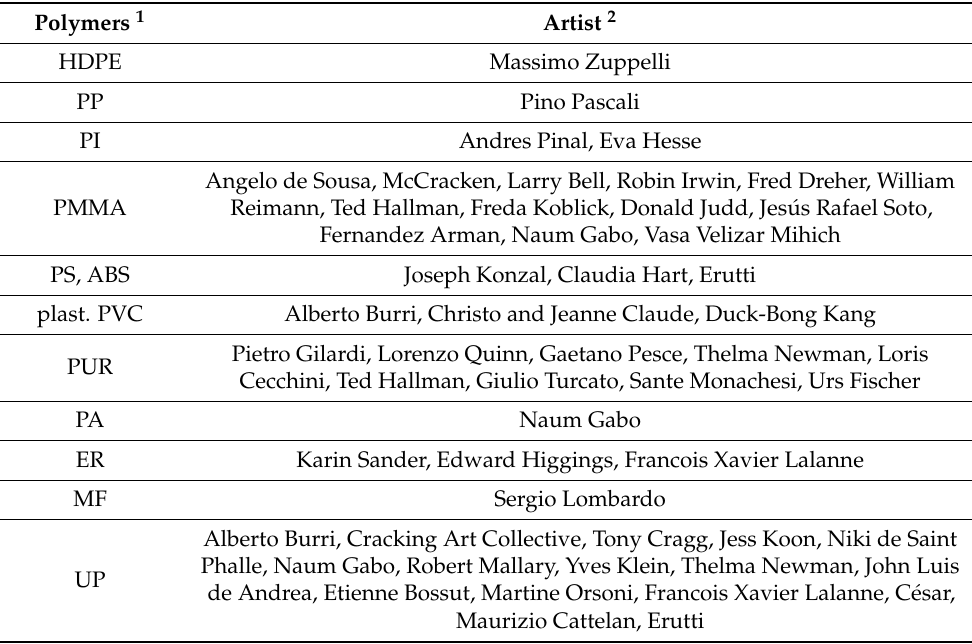
Table 1. Synthetic polymers used in contemporary art sculptures and